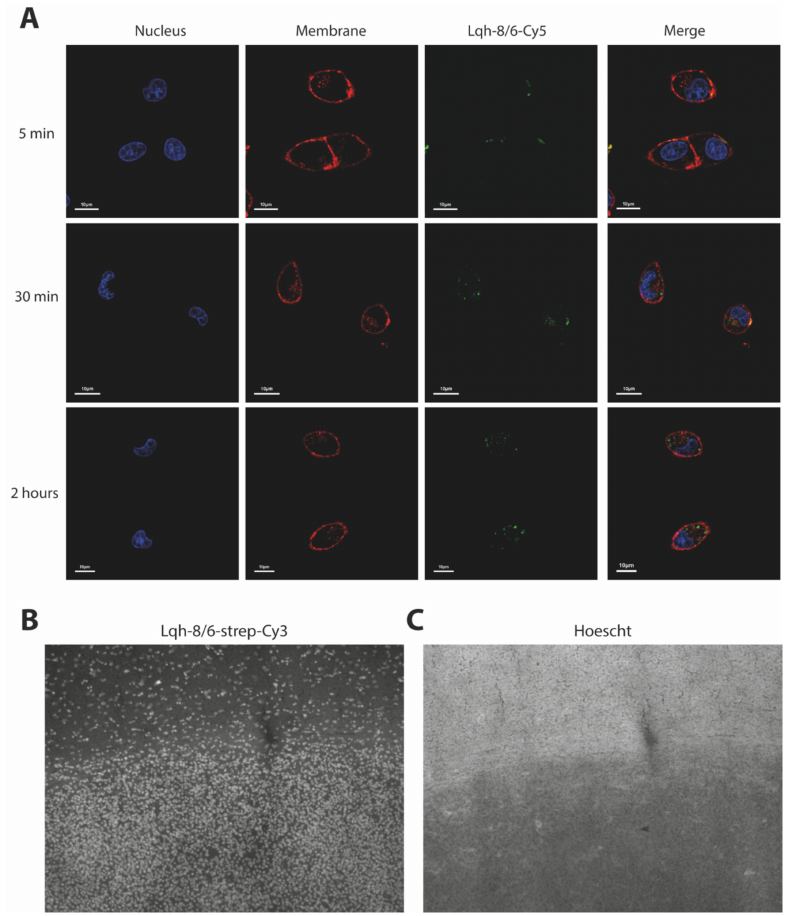
Figure 2. GBM F98 labeling with Lqh-8/6 b . ( A ) Confocal microscopy images illustrating the cell surface labeling and penetration of Lqh-8/6 b -strep-Cy5 into glioma F98 cells (green color). Incubation times were 5, 30 min and 2 h. Images were taken immediately after washout of the extracellular peptide. The plasma membrane is labeled with concanavalin-A-rhodamine (red color) and the nucleus with Hoechst 34,580 (blue color). (B ) Brain slice of F98 tumors in allograft Fischer rat labeled with Lqh-8/6 b -strep-Cy3. ( C ) Hoechst staining showing position of cell nuclei and density of F98 cells in brain